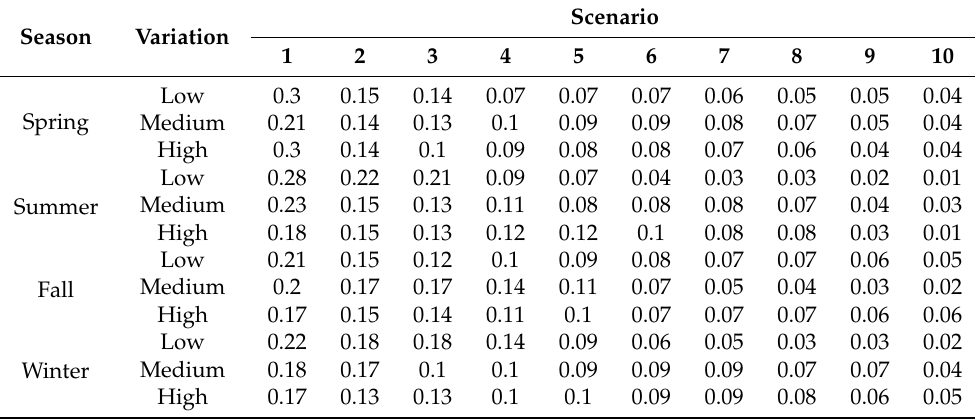
Figure 5. Scenarios of renewable energy variations in four seasons.